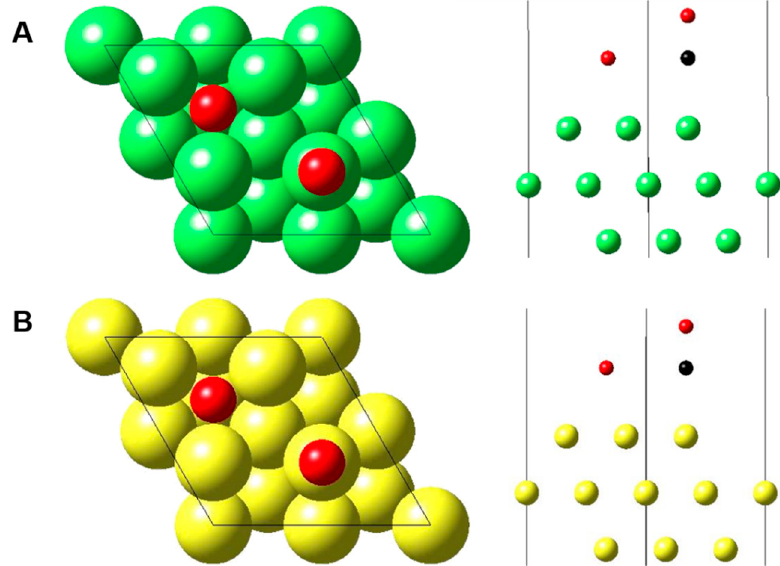
Figure 8. Illustration of CO and O a adsorption on ( A ) Ir(111) and ( B ) Pt(111) surfaces. Ir, Pt, O and C atoms are represented in green, yellow, red and black, respectively.